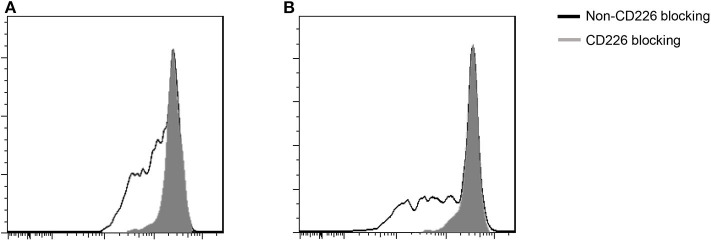
Influence of CD226 blocking on the proliferation of T cells from PBC patients. (A) CD8+ T cells; (B) CD4+ T cells.